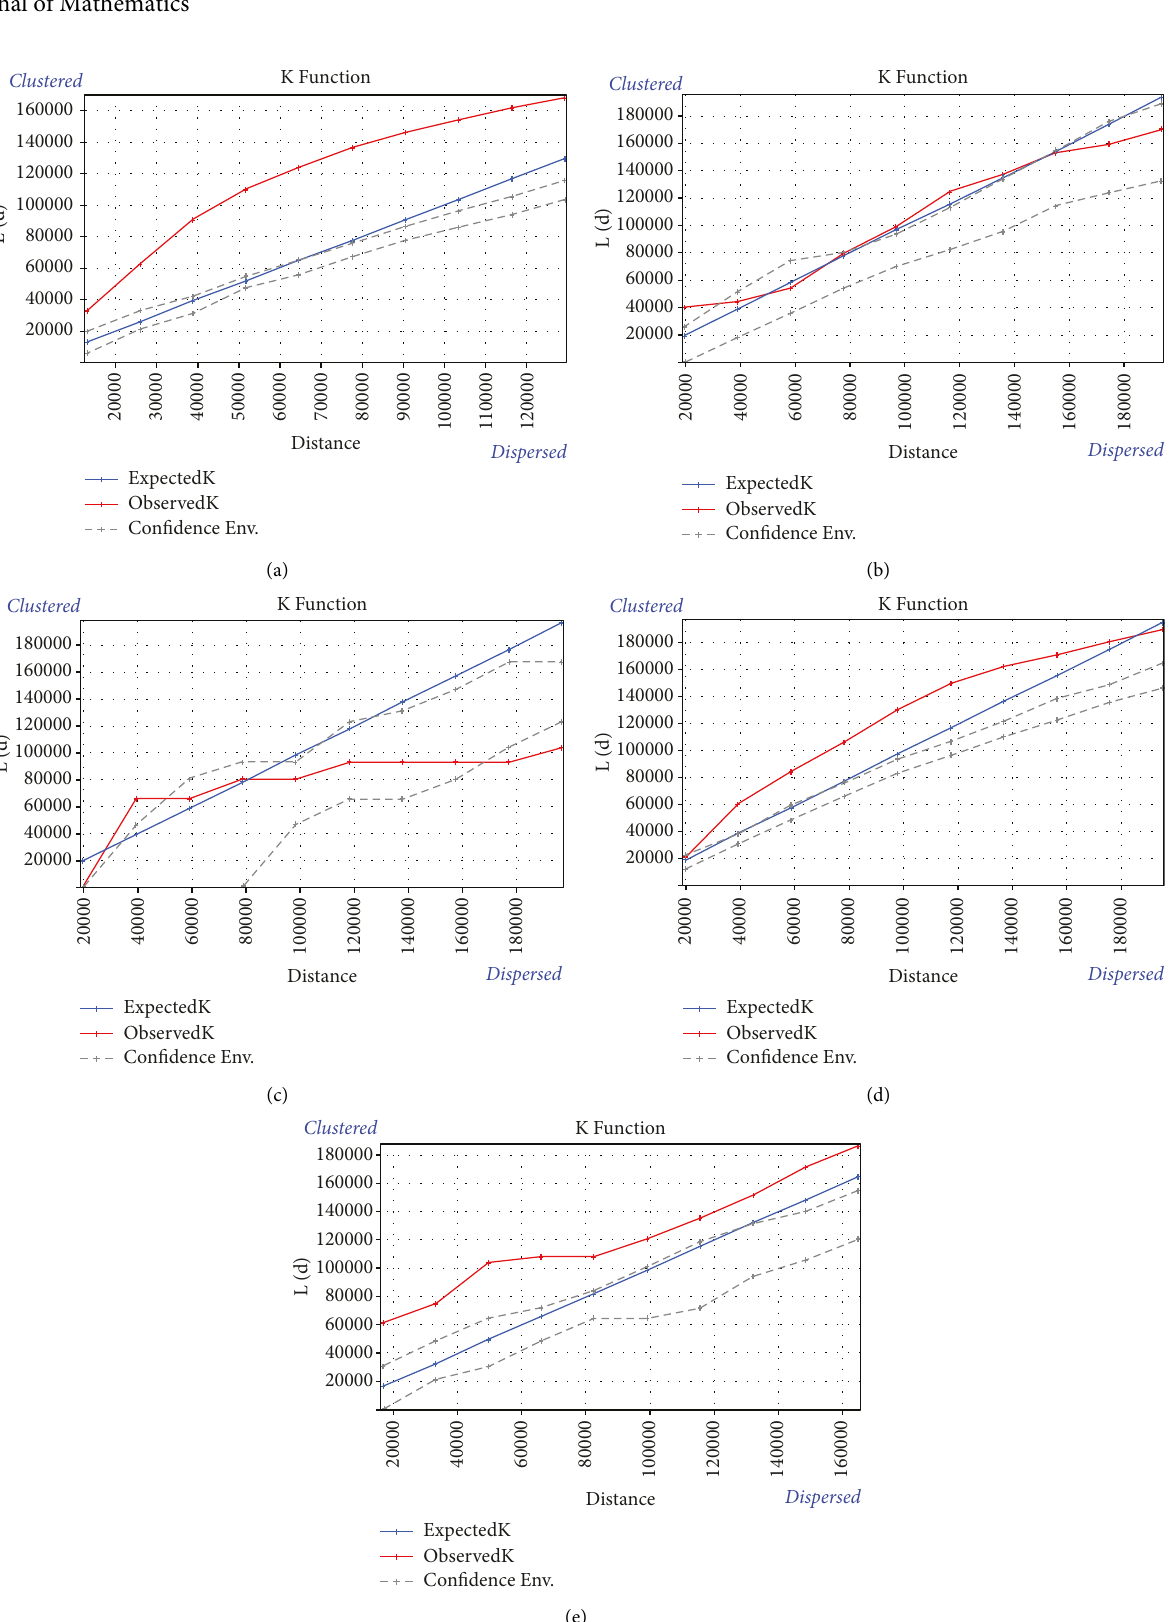
Figure 4: Ripley’s K function of various types of Characteristic Towns in Guangdong Province (a) Industrial development; (b) Agricultural service; (c) Commercial circulation; (d) Cultural tourism; (e) Innovative and